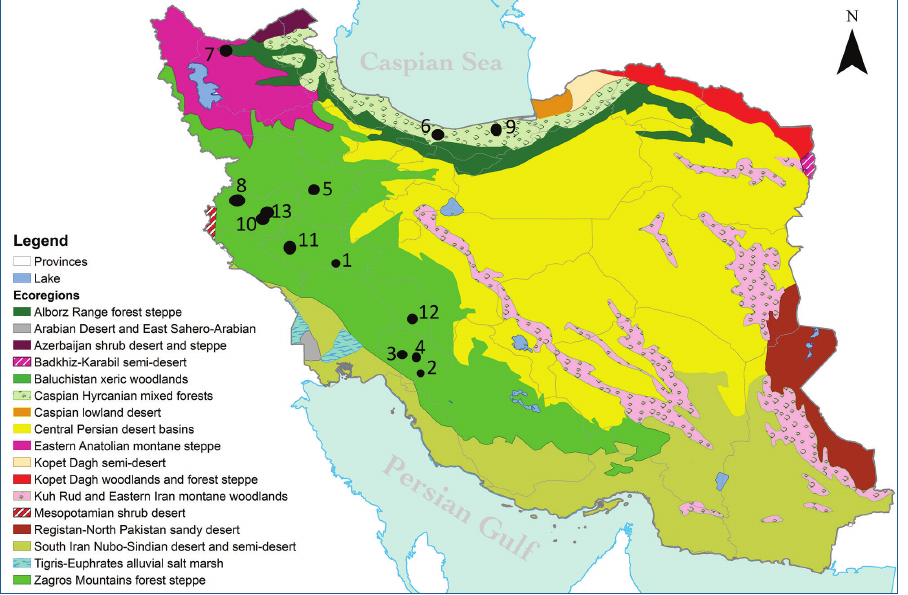
Figure 1. Map of terrestrial ecoregions in Iran, showing the distribution of troglobiotic organisms (16 species). Map derived from WWF (Olson et al. 2001) and Safaei-Mahroo et al. (2015). 1 Loven Cave (Lorestan Province) (33°04'N, 48°35'E) Garra typhlops ; G. lorestanensis ; Paracobitis smithi 2 Gakal Cave (Kohgiluyeh and Boyer-Ahmad Province) (30°18'N, 51°09'E) Protracheoniscus gakalicus ; Trilacuna qarzi 3 Neyneh Cave (Kohgiluyeh and Boyer-Ahmad Province) (30°40'N, 50°2'E) Chiraziulus troglopersicus 4 Belqais Spring (Kohgiloyeh and Boyer-Ahmad Province) (30°45'N, 50°44'E) Niphargus borisi 5 Alisadr Cave (Hamedan Province) (35°16'N, 48°17'E) Niphargus alisadri 6 Danial Cave (Mazandaran Province) (36°41'N, 50°53'E) Niphargus daniali 7 Cheshmeh Kahriz (Qanat) (East Azarbayjan Province)